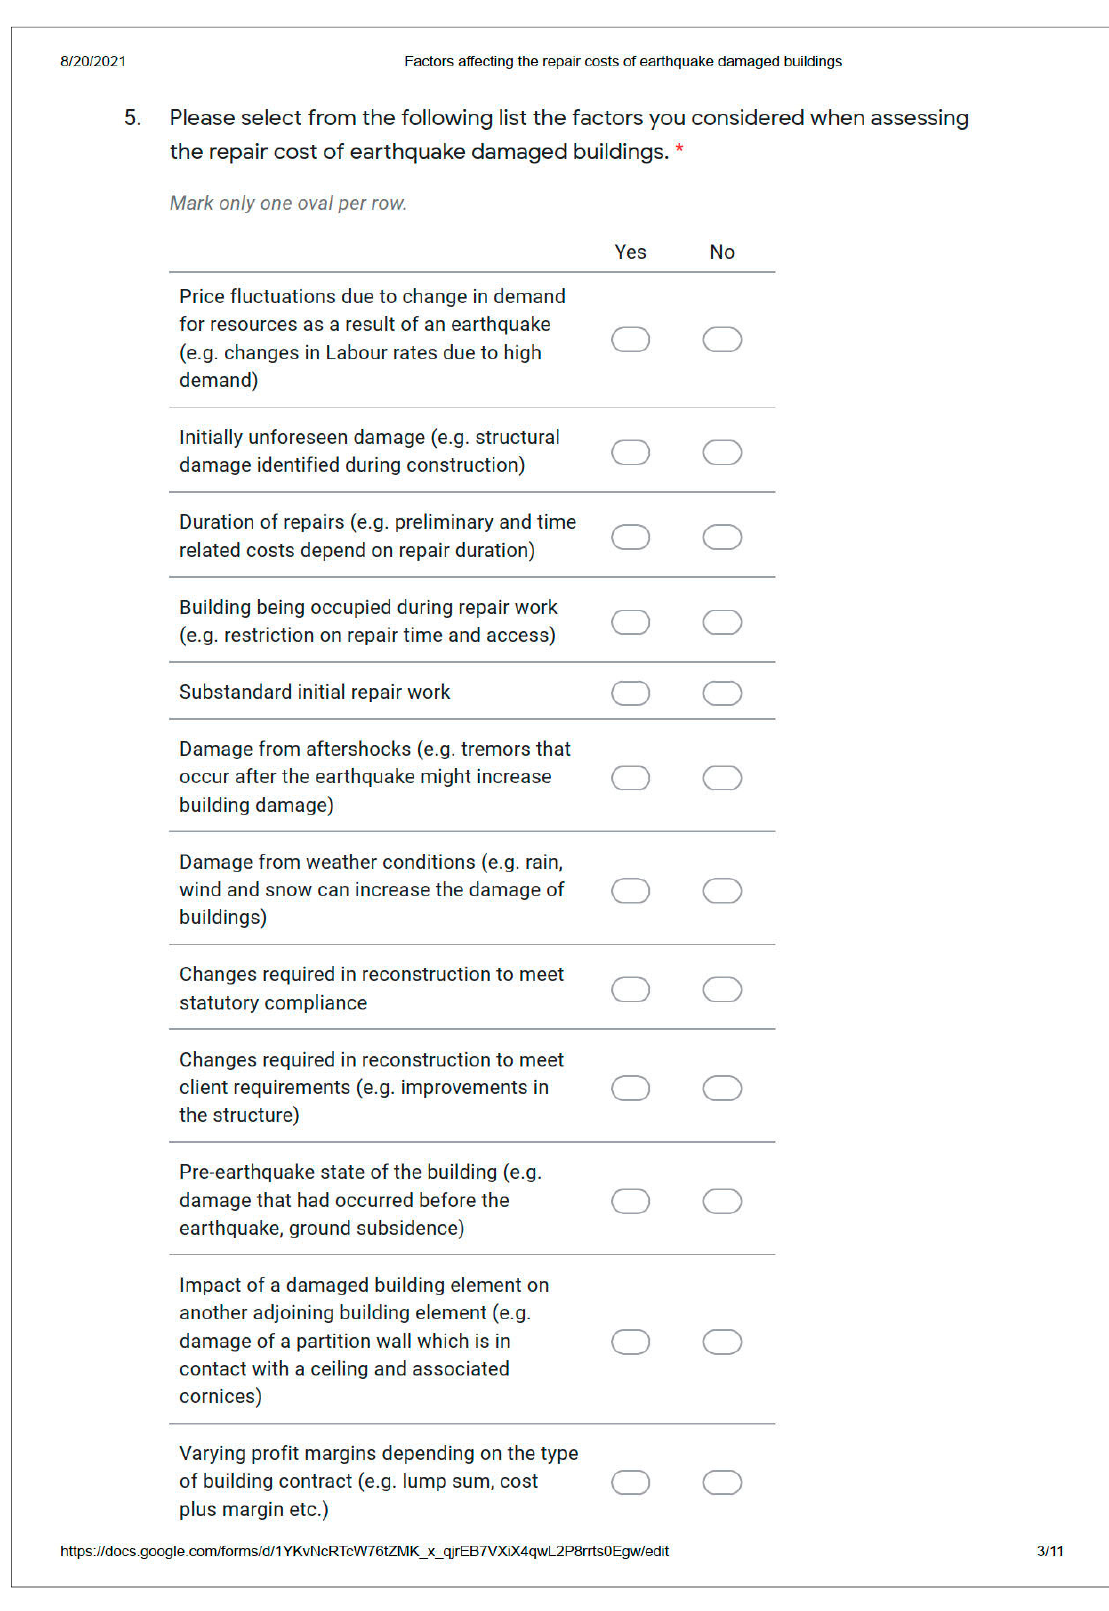
Figure A3. Questionnaire design (sample 3).